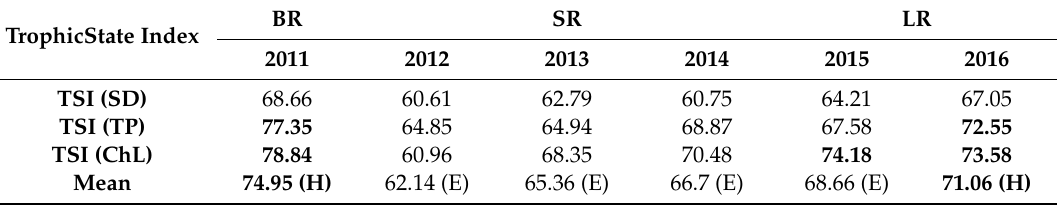
Table 2. Trophic state index for the waters of the epilimnion in Swarz˛edzkie Lake in